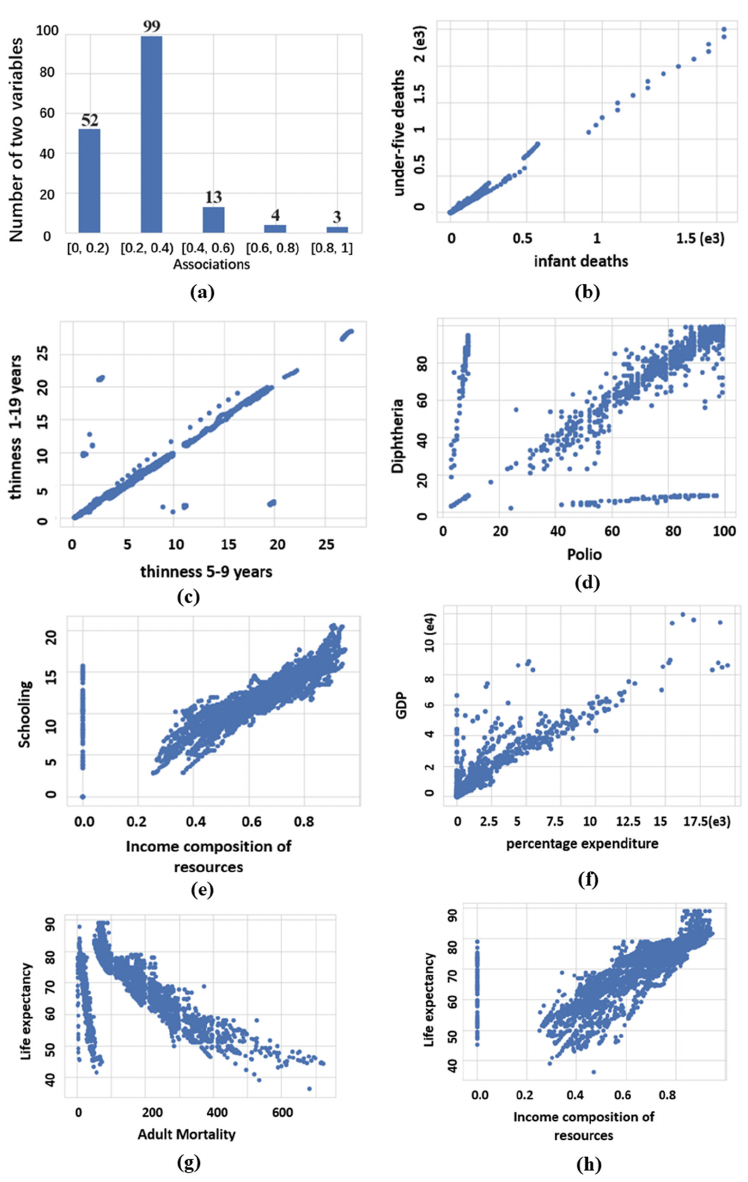
Figure 10. Exploring GHO dataset for bivariate associations with MIC.